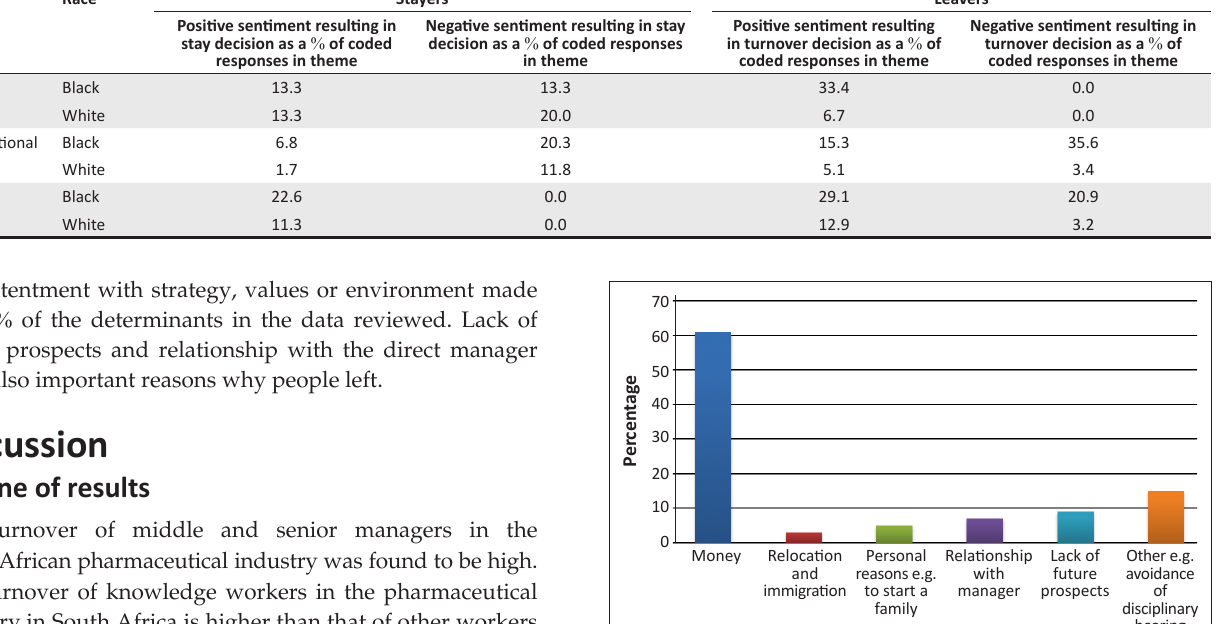
TABLE 6: Number of responses by major code. Factor Race Stayers